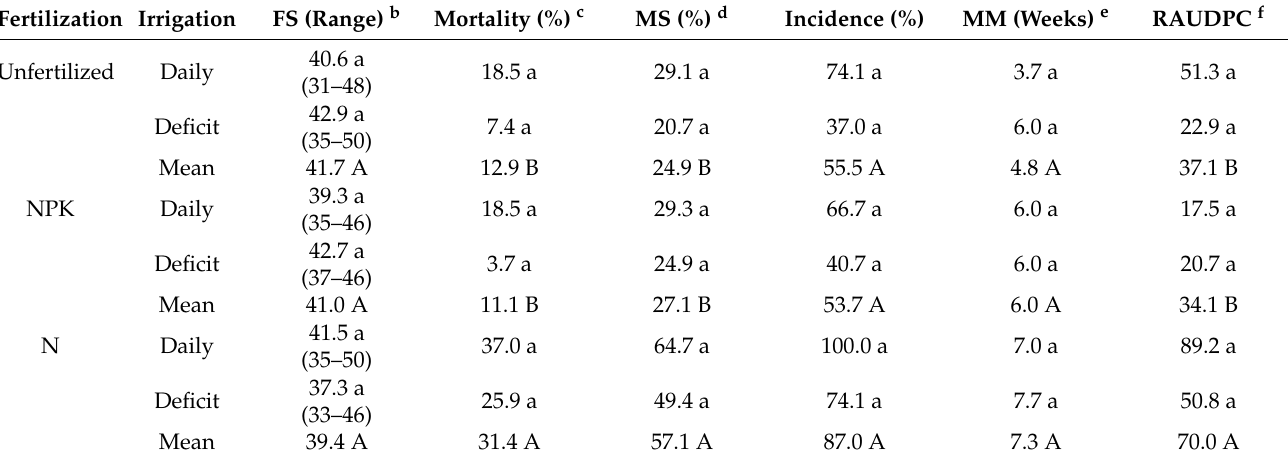
Table 1. Effect of fertilization treatments and irrigation frequency on the final estimated disease values for susceptible cultivar Picual in microplots of clay soil naturally infested by Verticillium dahliae a